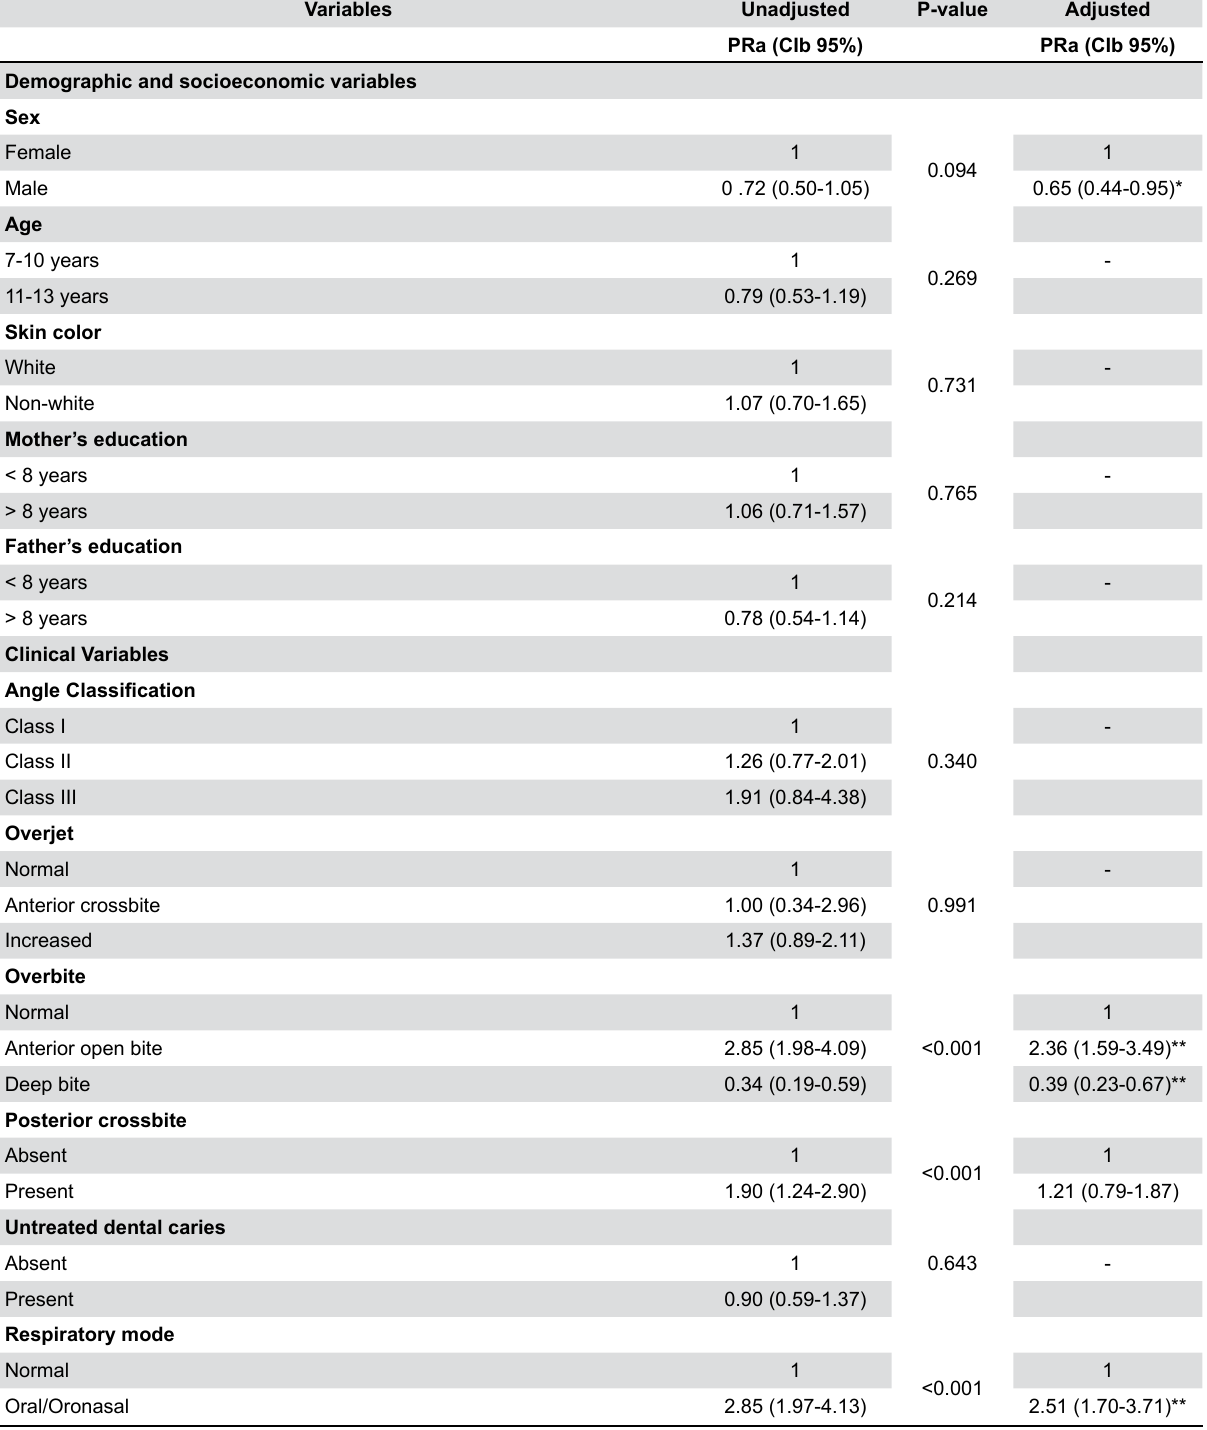
Table 3- Unadjusted and adjusted association between the independent variables for tongue position, determined using Poisson regression with robust